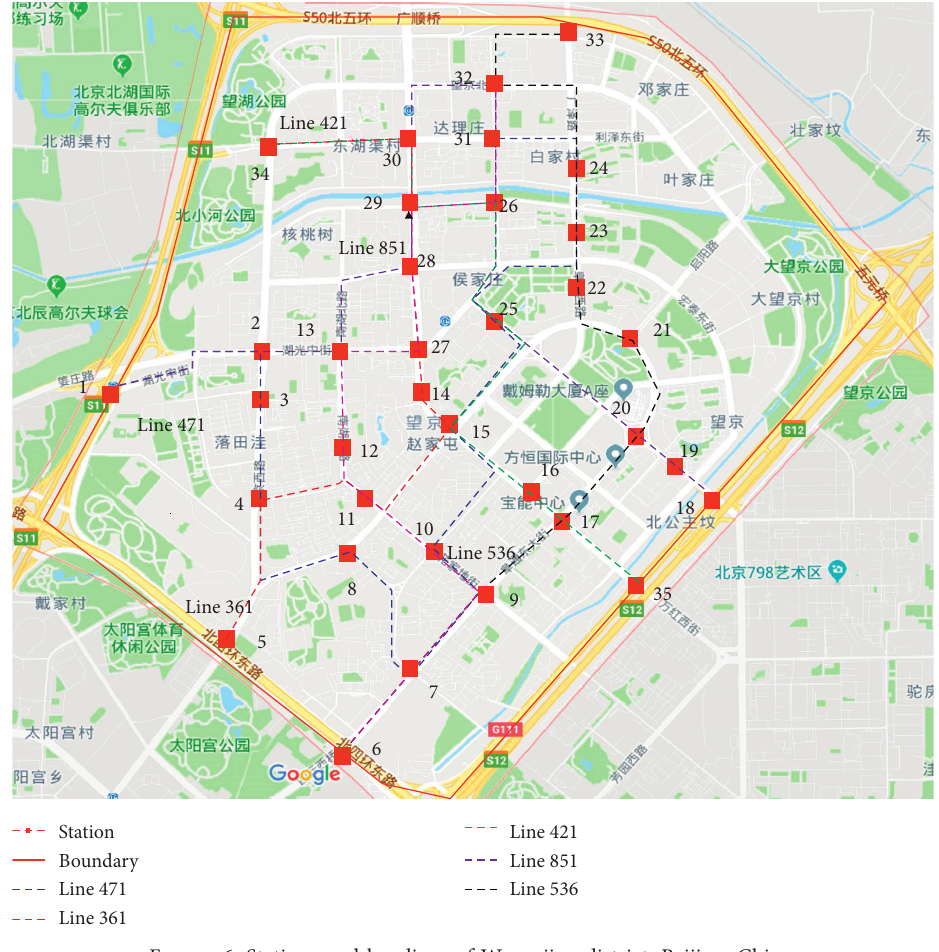
Figure 6: Stations and bus lines of Wang-jing district, Beijing, China.